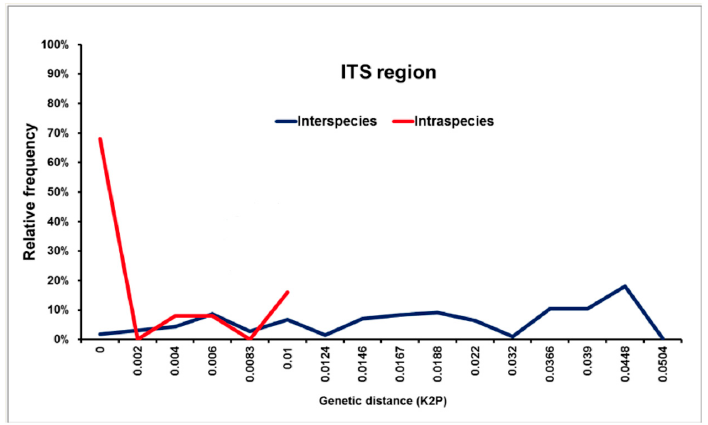
Figure 5. Distribution of interspecies (blue line) and intraspecies (red line) pairwise Kimura 2-parameter genetic distances in the genus Scedosporium based on the primary fun- gal DNA barcode the ITS1/2 region, based on 60 ITS1/2 sequences of Scedosporium angustum, Scedosporium aurantiacum, Scedosporium apiospermum, Scedosporium boydii, Scedosporium cereisporum, Scedosporium dehoogii, Scedosporium desertorum, Scedosporium ellipsoideum, Scedosporium fusoideum and Scedosporium minutisporum . No DNA barcoding gap was identified using the ITS1/2 region. All taxa were subjected to pairwise sequence divergence calculations using the Kimura 2-parametric distance model (K2P) in MEGA ver.